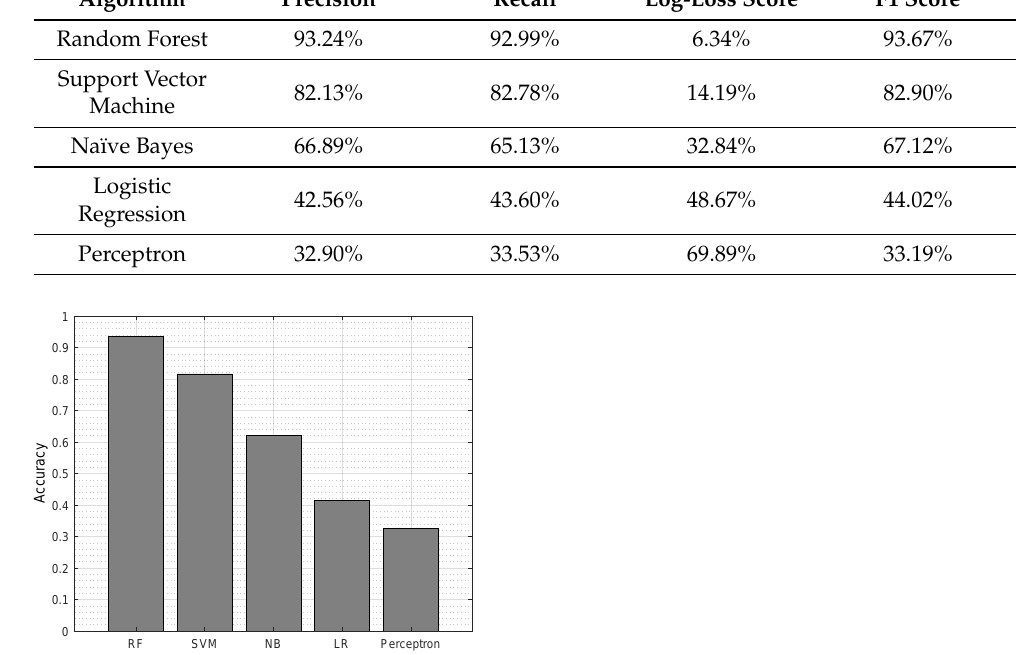
Figure 8. Evaluation of the intelligence layer where different AI-based algorithms are trained using a standard dataset and validated using a generated dataset from the malware